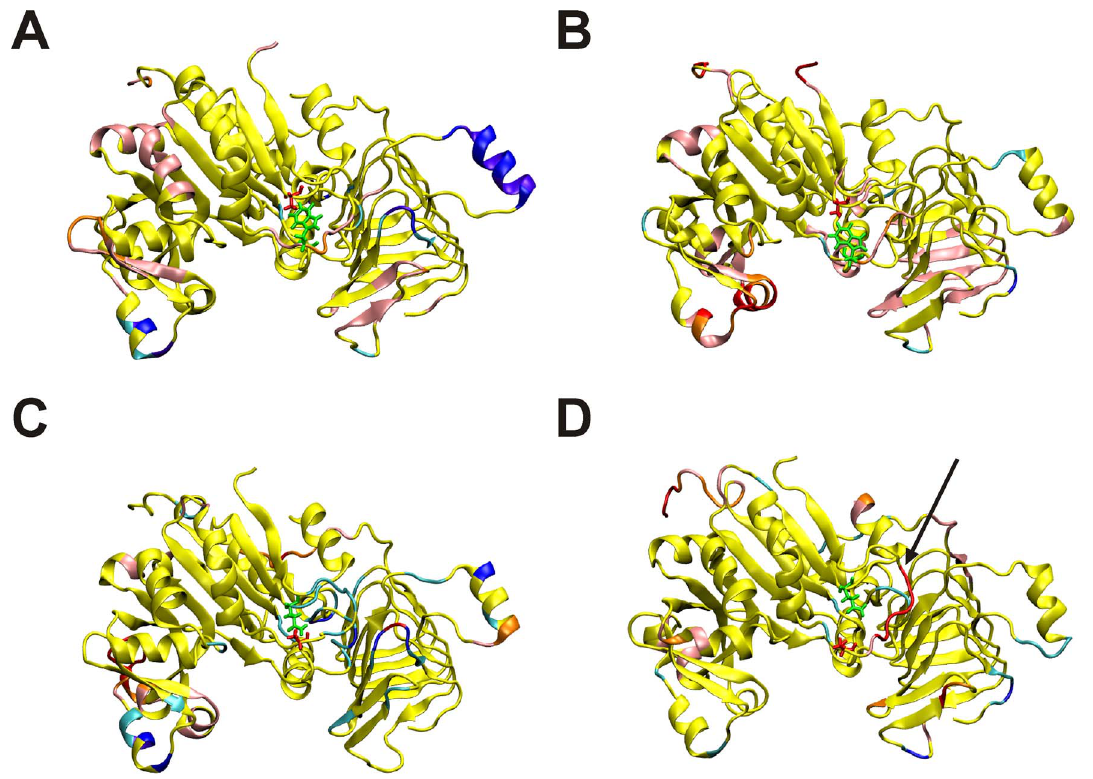
Figure 5. Changes in the molecular dynamics simulations due to mutations in the subunits. The structures are colored according to the difference RMSF values. Colors used are purple, more than 3 standard deviations negative; dark blue, 2 to 3 standard deviations negative; light blue, 1 to 2 standard deviations negative; yellow, + / 2 one standard deviation; pink, 1 to 2 standard deviations positive; orange, 2 to 3 standard deviations positive; and red, more than 3 standard deviations positive. A. Stu S Q75A . B. Stu L Q86A . C. Stu S W116A . D. Stu L W128A . The position of the residue mutated to Ala is shown in red, while the non-mutated position is shown in green. The values of the standard deviations were Stu S Q75A , 0.38; Stu L Q86A , 0.40; Stu S W116A , 0.40; and Stu L W128A , 0.43. Because of the different flexibilities, the Trp-containing loop that was mutated is in different colors. It is shown in red in panel D